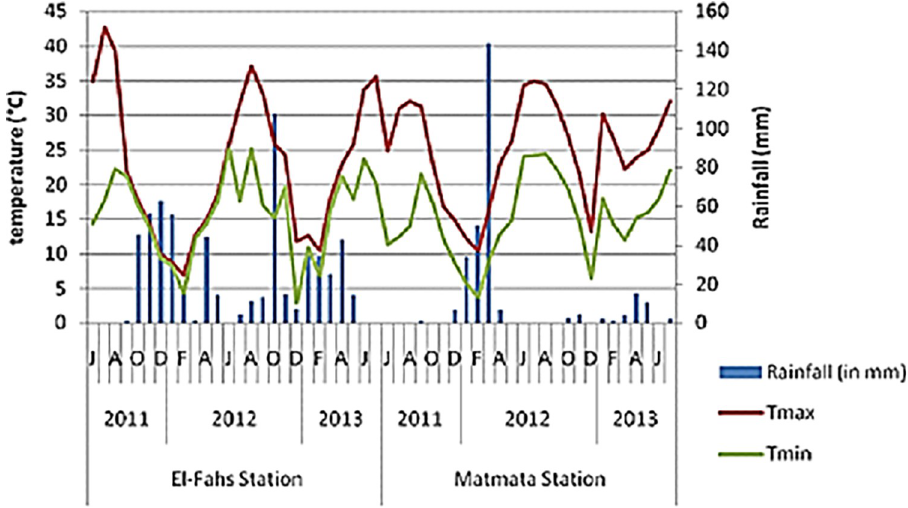
Fig 1. Variations of the pluviometry and the monthly maximal and minimal temperatures of the experimental